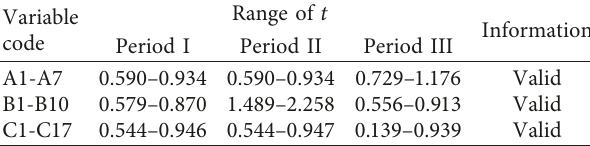
Table 4: Characteristic of respondents.